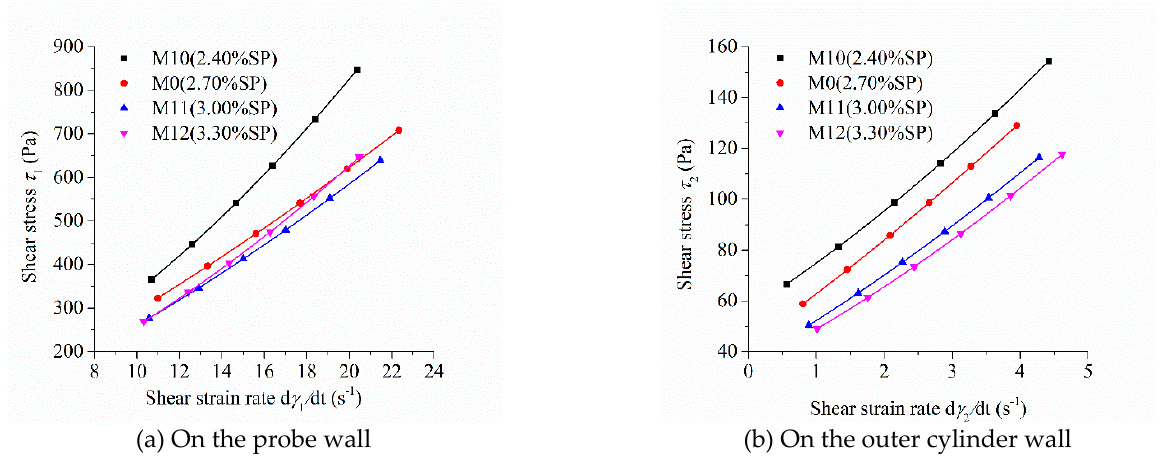
Figure 8. Relationship between the shear stress and shear strain rate of mortars with different dosages of superplasticizer (SP).